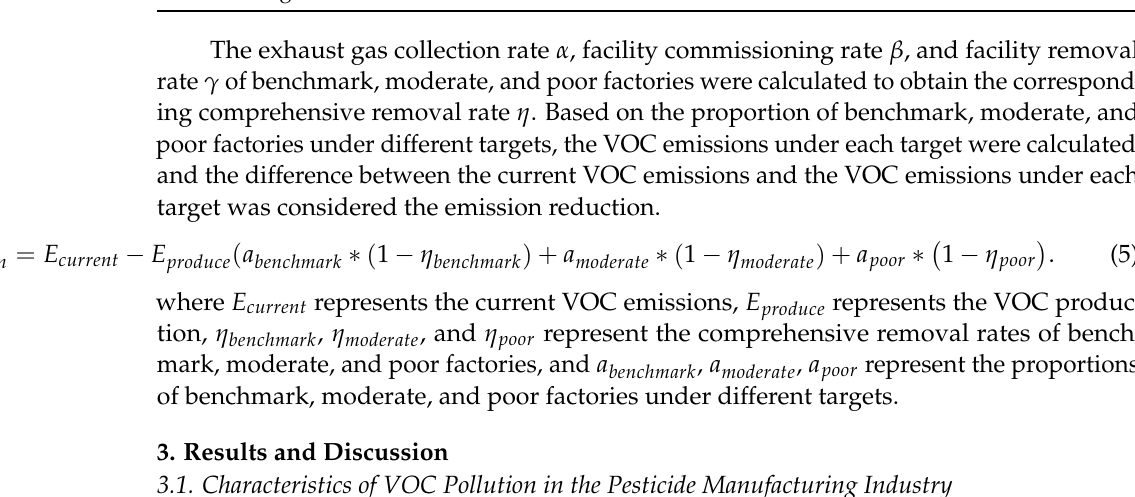
Table 1. Three different levels of VOC emission reduction targets in pesticide factories in China. Proportion of Factories (%) Target Levels Benchmark Moderate Poor Low 20 65 15 Moderate 30 60 10 High 40 58